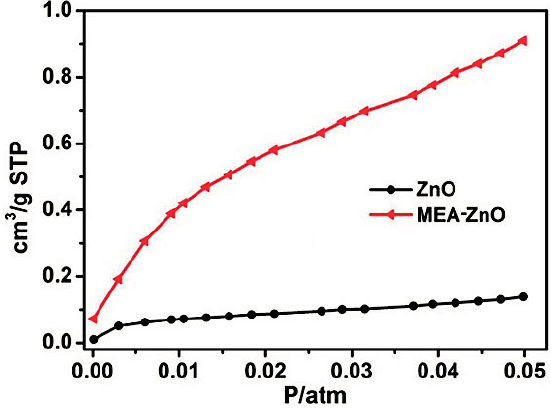
Figure 4. CO 2 adsorption isotherms of MEA–ZnO and clean